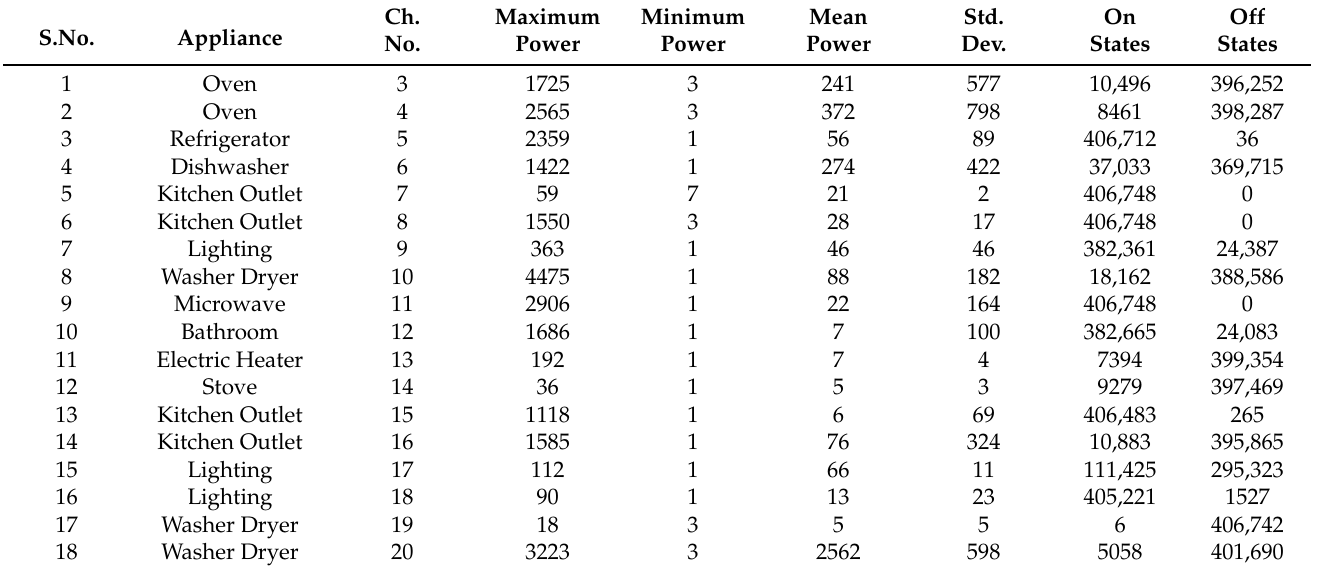
Table 1. REDD House 1 appliance parameters.